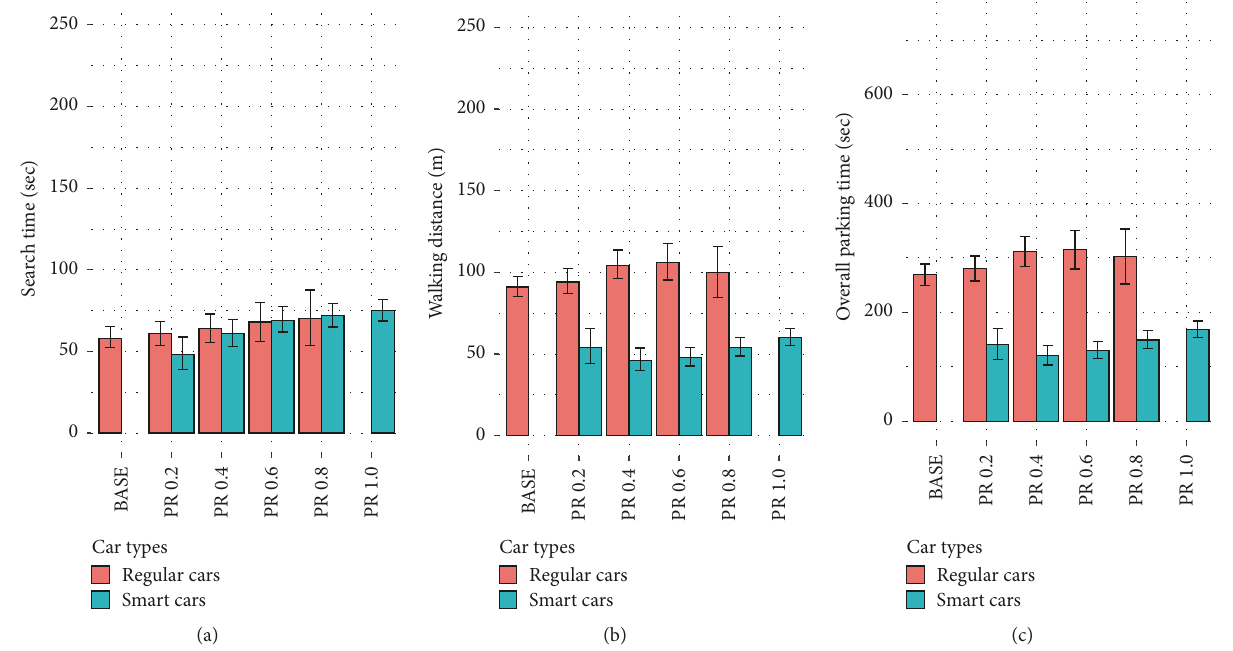
Figure 3: Results for individual drivers for on-street parking: (a) search time, (b) walking distance, and (c) total parking time, for regular cars and smart cars, for a 95% confidence interval at afternoon peak